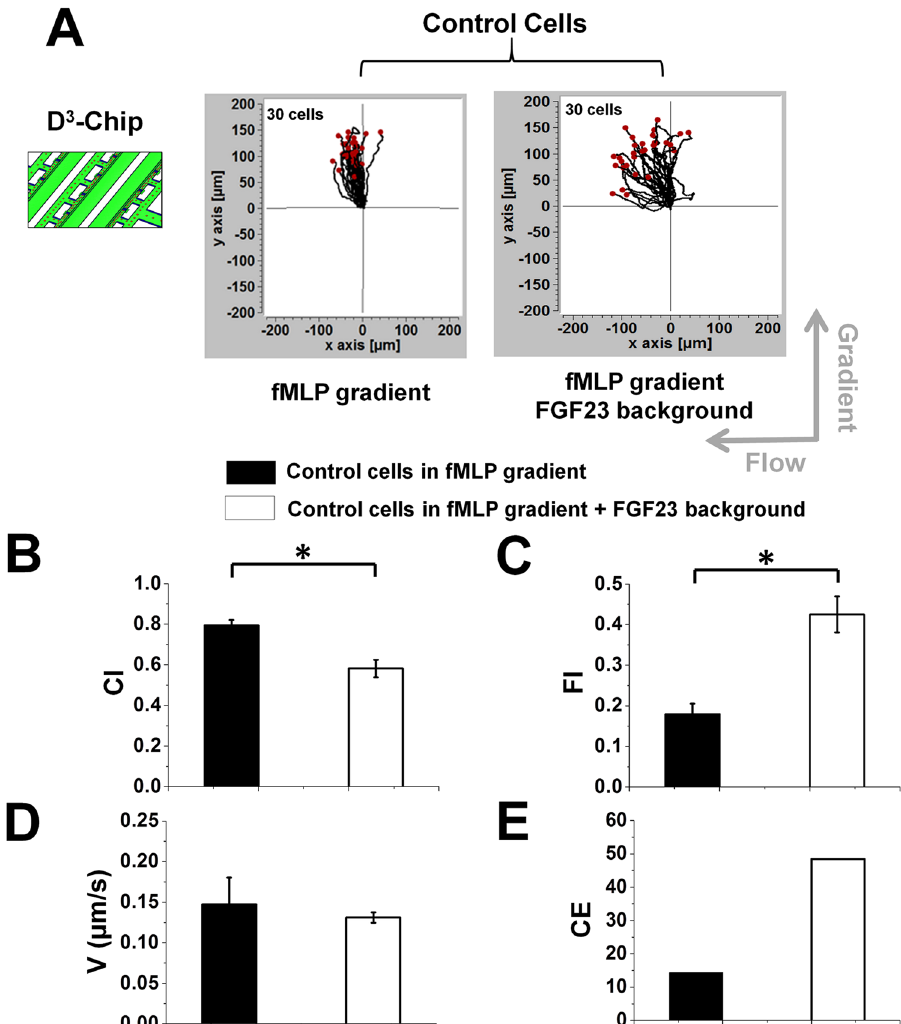
Figure 5. Chemotaxis of un-treated control cells with or without active FGF23 exposure in the D 3 -Chip. Cell migration tracks of control cells in a 100 nM f MLP gradient with (right plot) or without (left plot) a FGF23 uniform background in the D 3 -Chip. The cell tracks are normalized to have the same starting point in the plot. The gradient direction, the flow direction and the number of cells for each plot are indicated; ( B – E ) Comparison of quantitative cell migration parameters including chemotactic index (CI), flowtactic index (FI), speed (V) and chemotactic entropy (CE). The data for each parameter are presented as the average of all cells from representative experiments. The error bar indicates the standard error of the mean. * Indicates p < 0.05 for comparison between specific conditions using the Student’s t